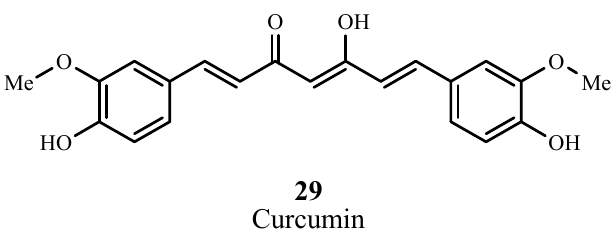
Figure 20. Example of a curcuminoid PDT sensitizer.